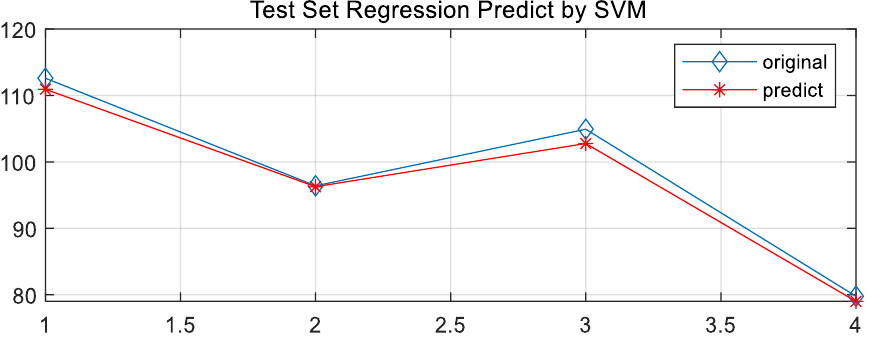
Figure 12. GA-cg parameter optimization fitness curve.